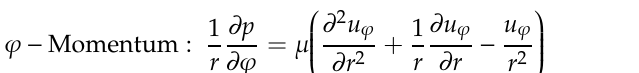
Figure 4. Simplified model 1 to obtain an analytical solution for (cid:1873) (cid:3101) (cid:4666)(cid:1870)(cid:4667) in the radial gap. With these assumptions and under the premise of an incompressible and stationary two- dimensional flow, the Navier–Stokes equations in cylindrical coordinates could be simplified. All spatial derivatives in the circumferential direction, as well as all temporal derivatives, canceled out.